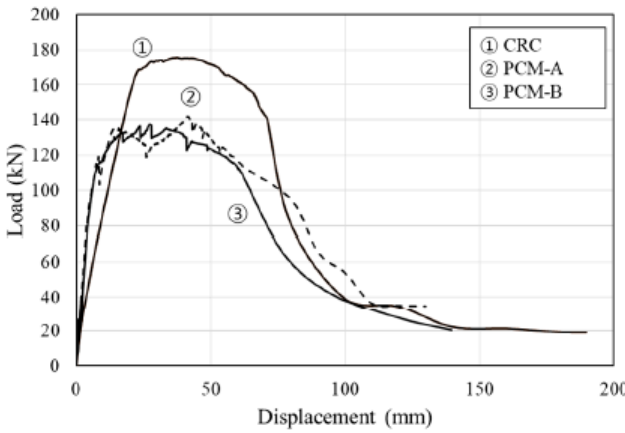
Figure 13. Load–displacement